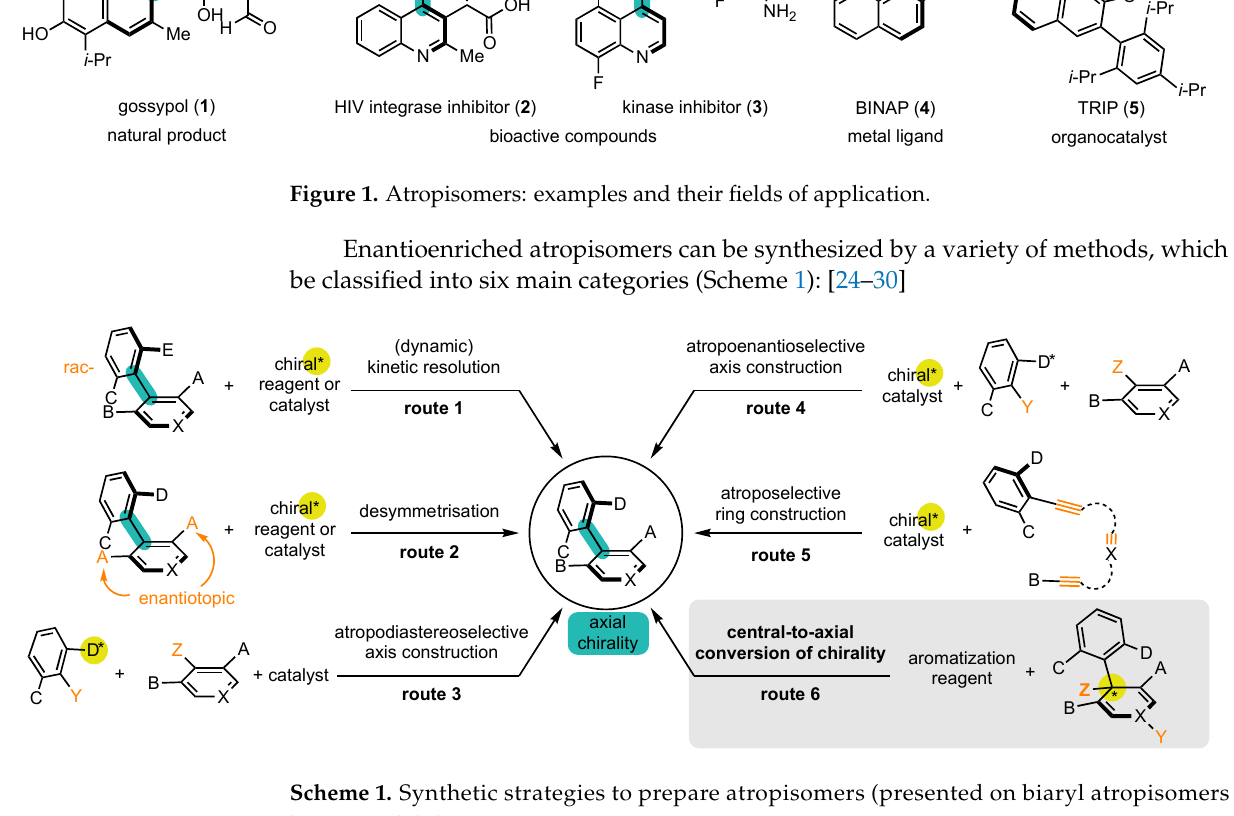
Scheme 1. Synthetic strategies to prepare atropisomers (presented on biaryl atropisomers for better